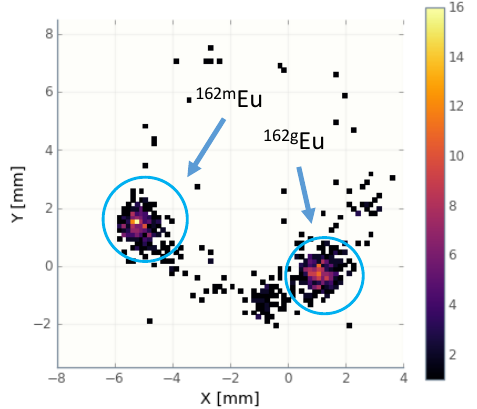
Figure 1. A histogram of a phase-imaging measurement show- ing the positions of 162 m ,g Eu ions on the detector plane.